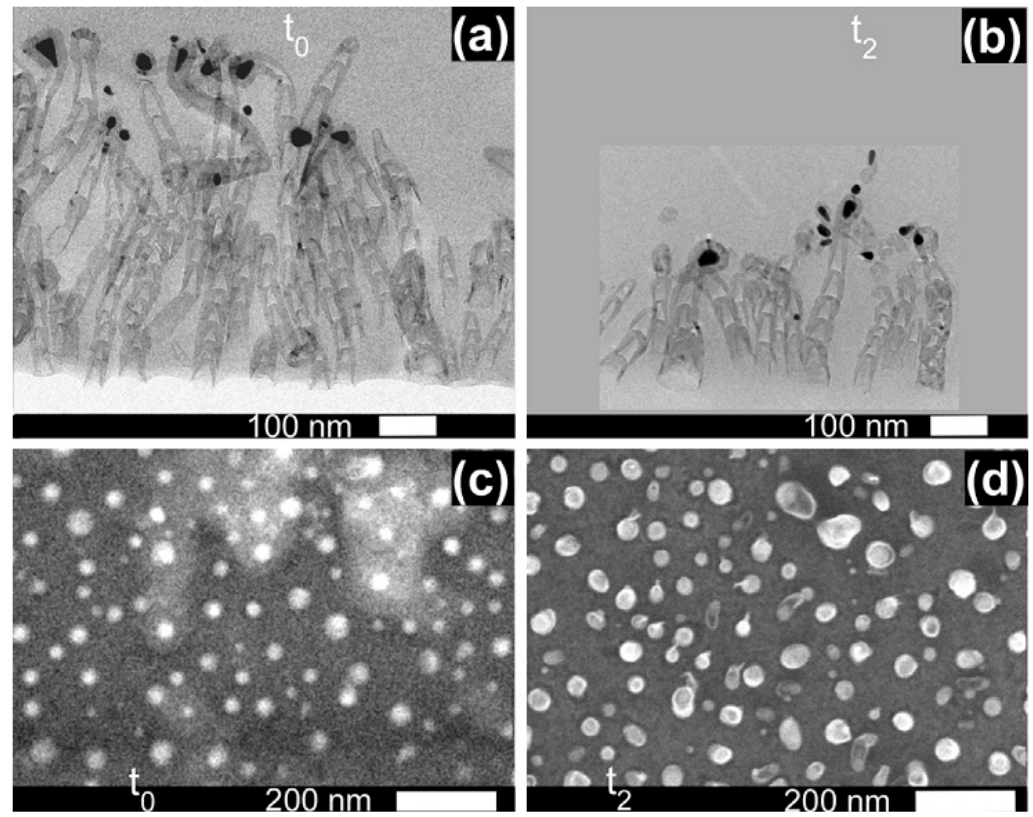
Figure 9. TEM images of Pt-CNT after a pretreatment of ( a ) 0 and ( b ) 3 min; Corresponding SEM images ( c , d ); respectively (reprinted with permission from Ref. [62], copyright 2011 Elsevier).